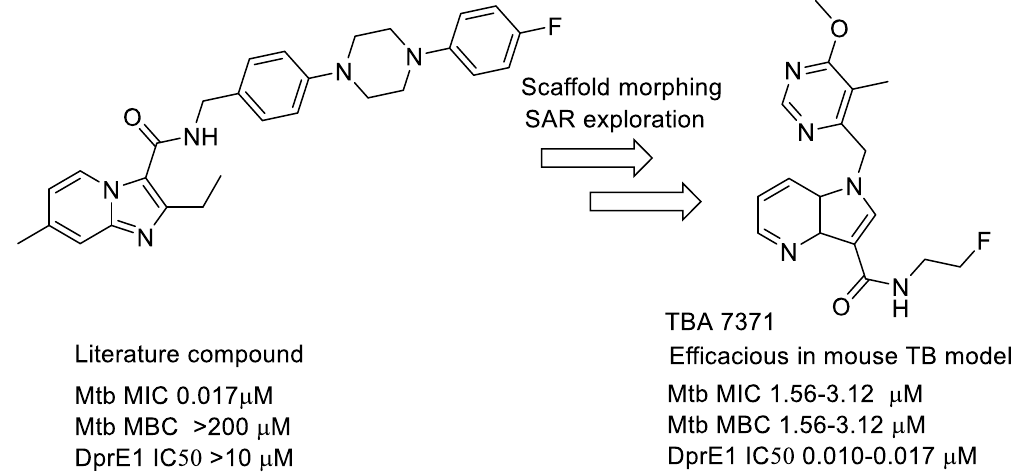
Figure 5. Evolution of TBA7371 which is in Phase 2A clinical trials in TB patients.